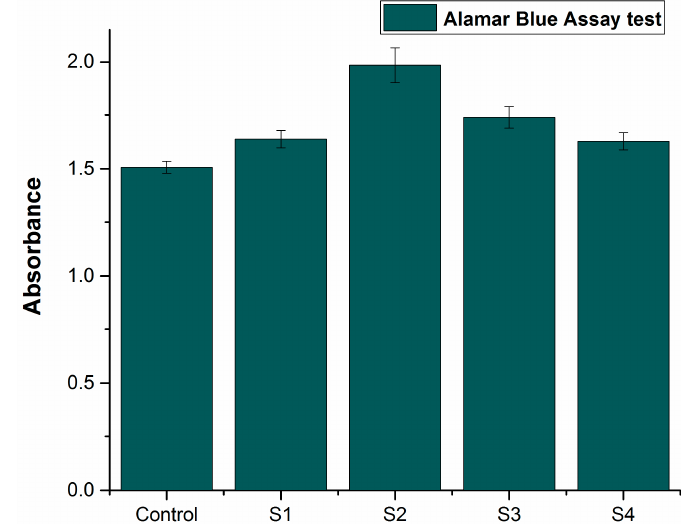
Figure 10. Comparison of control with samples.